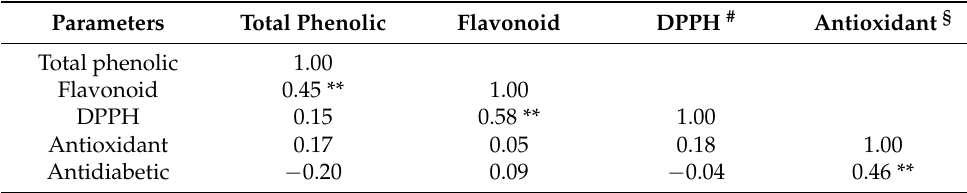
Table 3. Pearson correlation coefficient analysis for the phytochemical, antioxidant, and antidiabetic properties of cladodes from the 42 spineless cactus pear